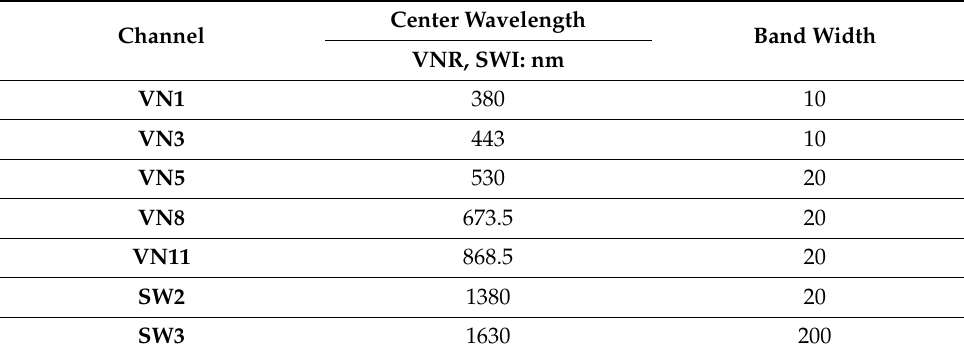
Table 6. Wavelength and wavelength range of SGLI channel, which are used in NNDT algorithm and true color composite